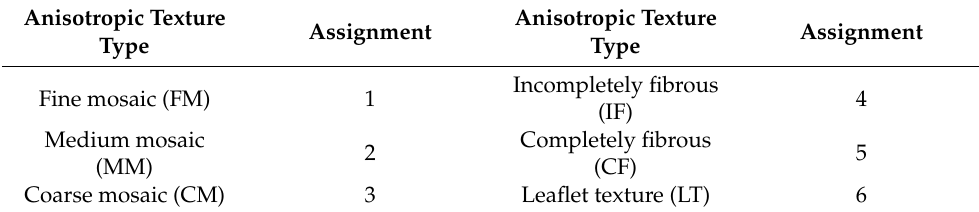
Table 8. A higher assignment value indicates a higher ordering structure. Table 8. Assignment value of each anisotropic type